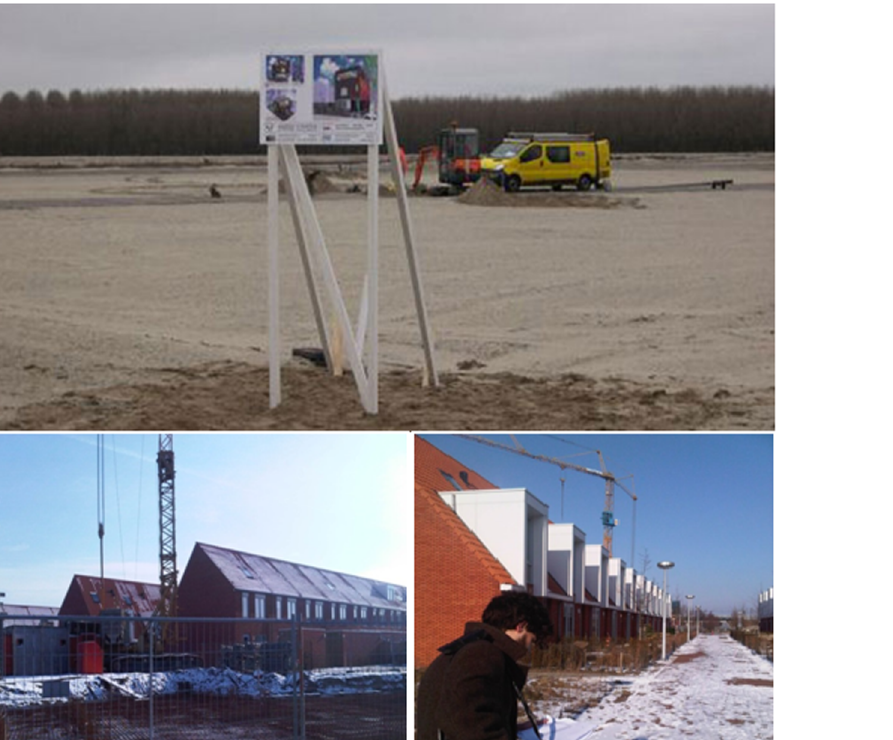
Figure 1a-c. Photo impression of the emergence of a so-called VINEX location. Figure 1a at the very start, Figure 1b after three and Figure 1c after seven